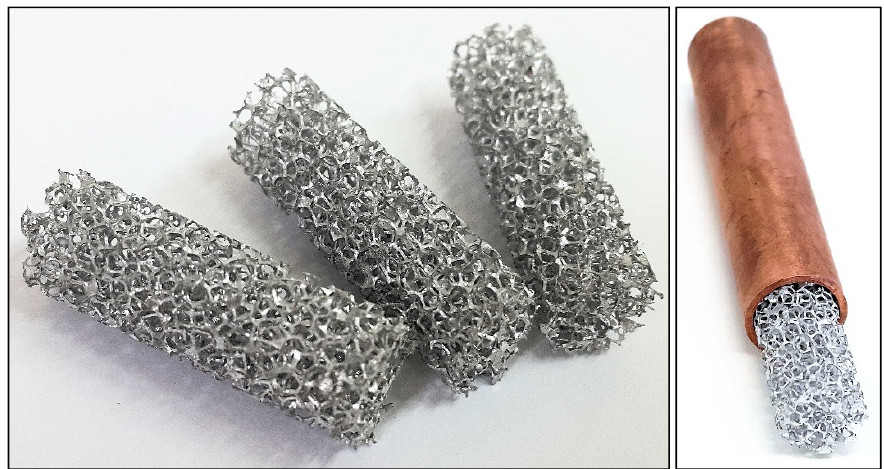
Figure 1. Cylinder-shaped metal foam elements applied in the experimental study.